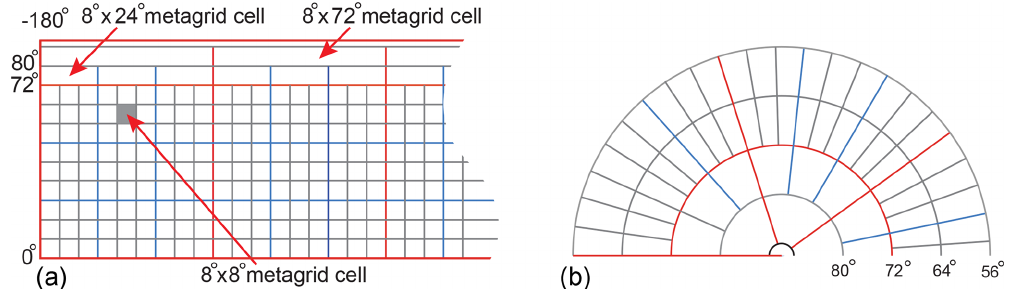
Figure 3. (a) The metagrid is shown above the Equator. For cells 8 × 8 and smaller the structure is a quadtree. (b) A polar view of the metagrid showing wider metagrid cells north of 72 ◦ .